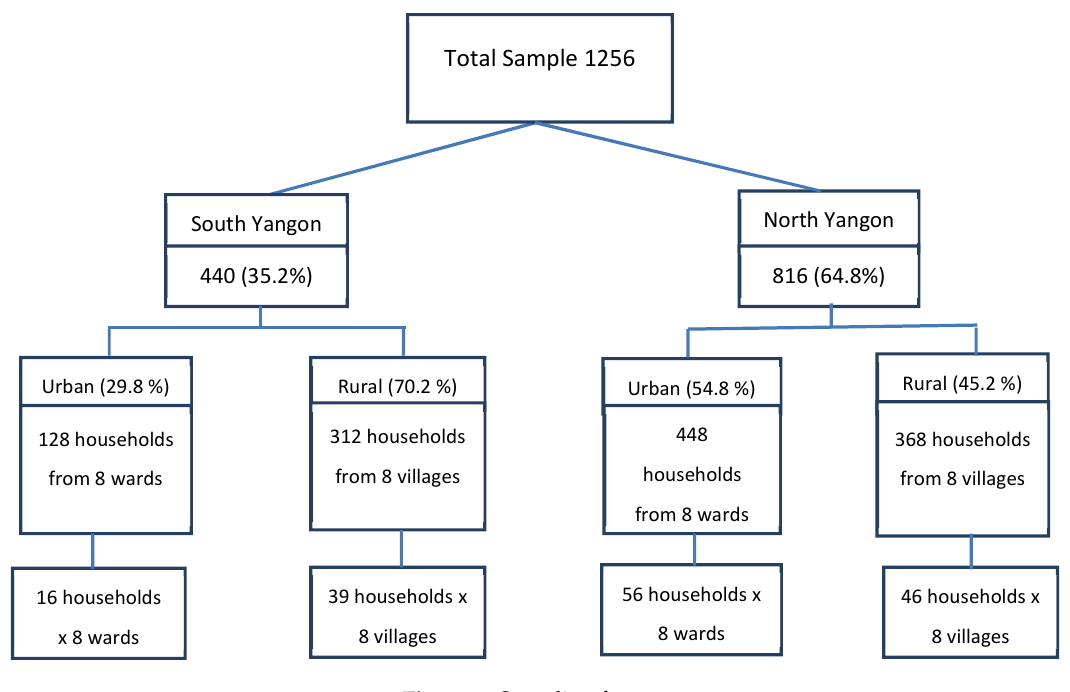
Figure 2. Sampling frame.